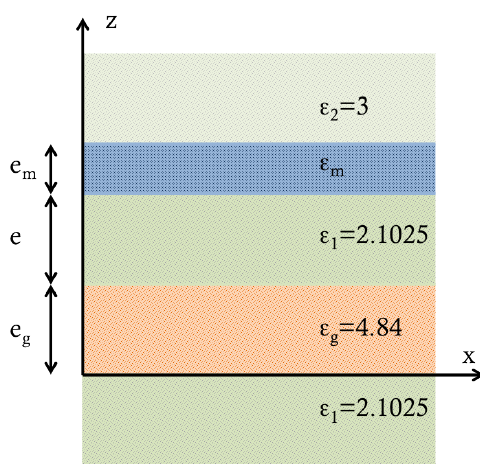
Figure 2: Multilayered structure with a dielectric waveg- uide ( ε g ) with e g = 130 nm and a metallic film ( ε m ) with e m = 45 nm inserted between two dielectrics hosts ( ε 1 and ε 2 ) and separated by a dielectric layer. The thickness e is the parameter which is going to change in the simulations.